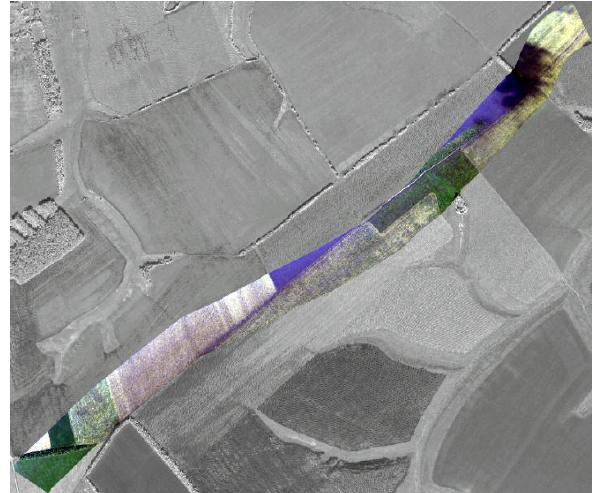
Image 4. A test image from the first series corrected with described algorithm.